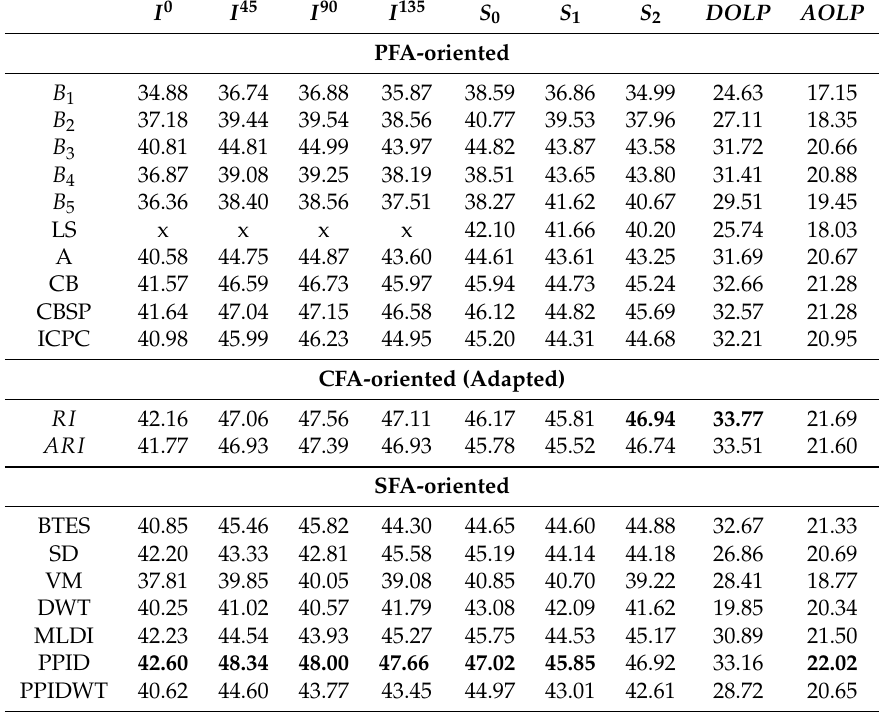
Table 4. Demosaicking peak signal-to-noise ratio (PSNR) results, which are averaged over all scenes of the testing database. The descriptors are computed using Equations (1)–(3). The best result for each channel or descriptor is highlighted as